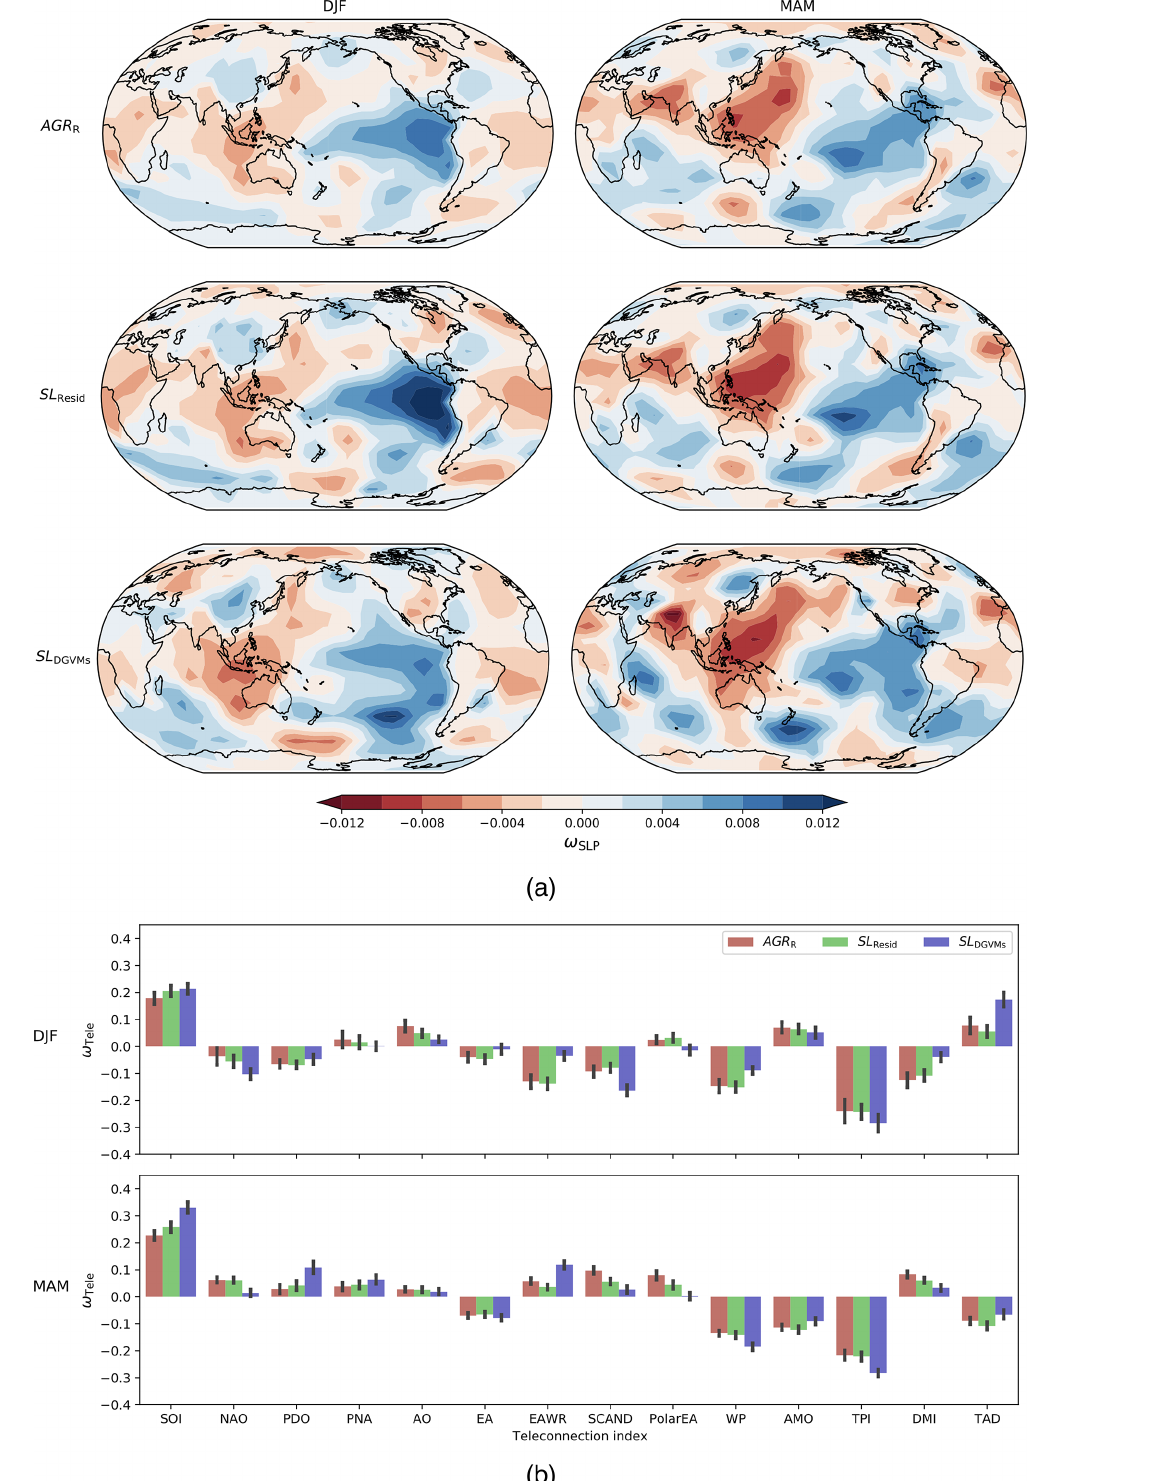
Figure 3. (a) Distribution of ridge regression coefficients of SLP with the time series of AGR R (top row), SL Resid (center row), and SL DGVMs (bottom row) in DJF (left column) and MAM (right column) based on SLP fields in the period 1959–2017. (b) Distribution of ridge regression coefficients of teleconnection indices with AGR R , SL Resid , and SL DGVMs . Both ω SLP and ω Tele are the mean of the n = 54 run ridge regression